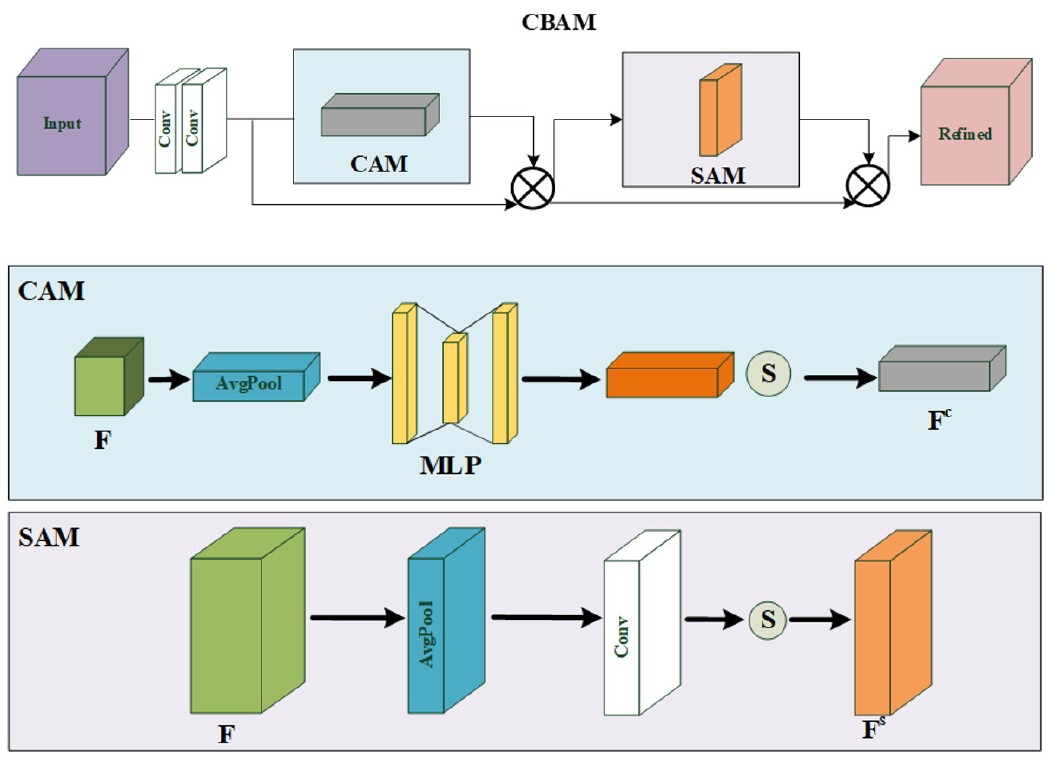
Figure 1. Detailed structure of CBAM.